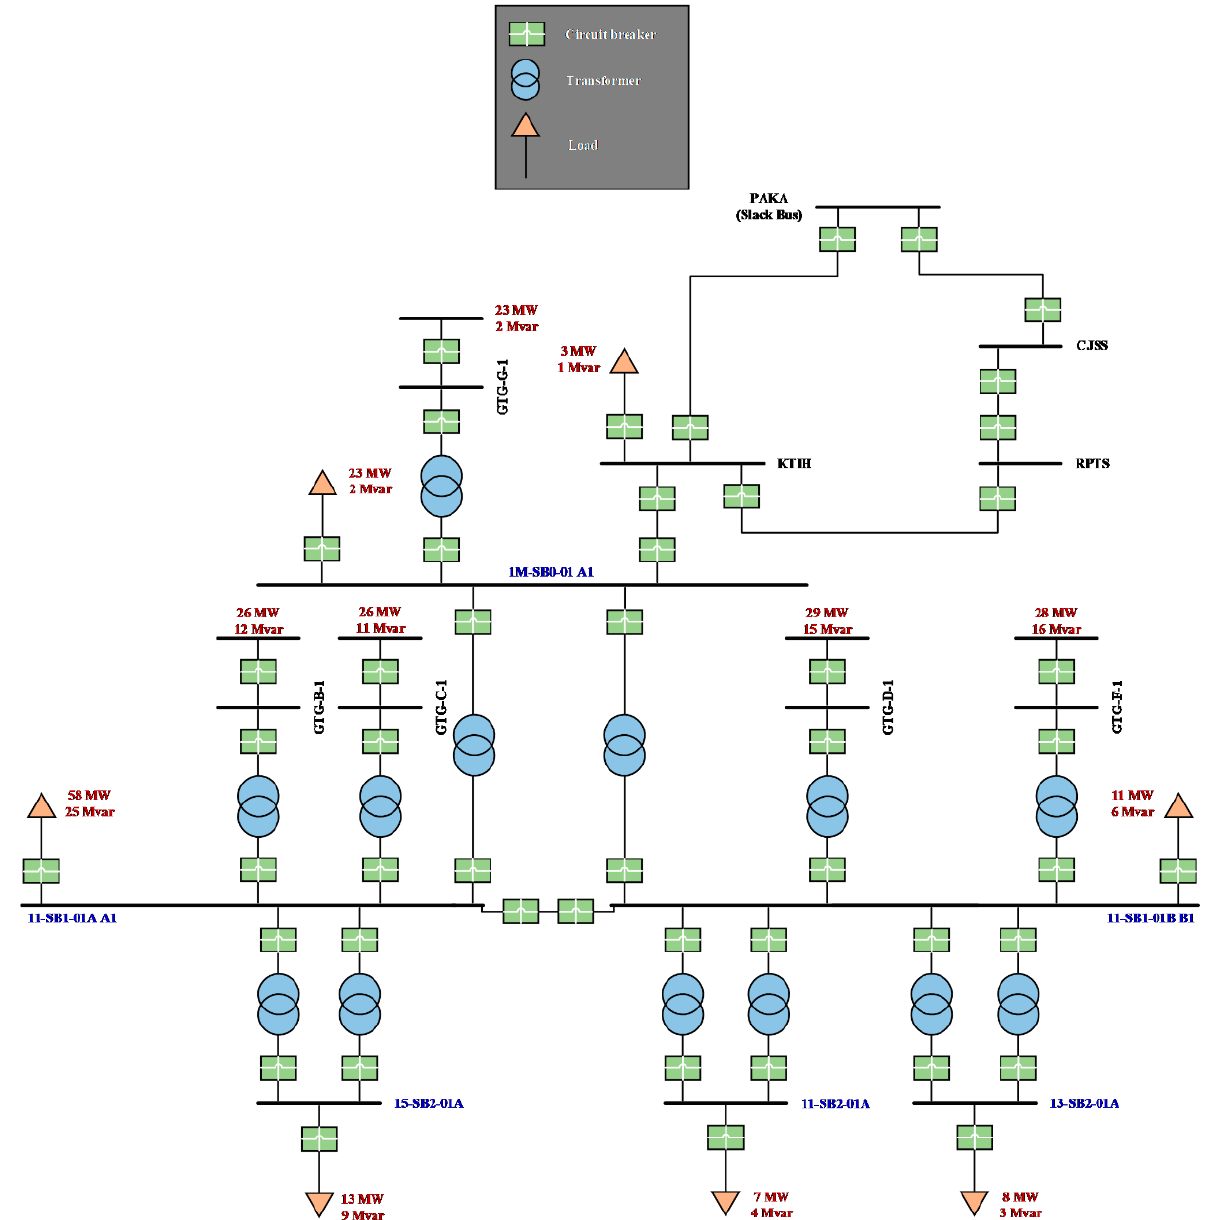
Figure 2. SLD of a Malaysian distribution system named Utility Kerteh. Table 2. Setting of parameters of the test system.